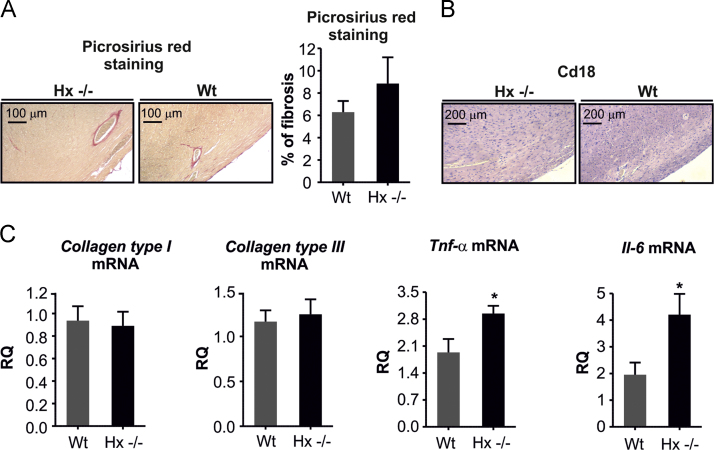
Hemopexin loss is not associated with heart fibrosis. Data on Wt and Hx-/- mice are shown. (A) Representative Picrosirius Red staining of heart sections from a Wt and an Hx-/- mouse. ImageJ analysis of Picrosirius Red stained sections is shown on the right. (B) Immunohistochemistry analysis of CD18 expression on heart sections of a Wt and a Hx-/- mouse. (C) qRT-PCR analysis of collagen type I and III, Tnf-α and IL6 mRNA levels in the heart (n = 5). Unpaired t-test analysis with Welch׳s correction was performed. Values represent mean ± SEM. *P<0.05.